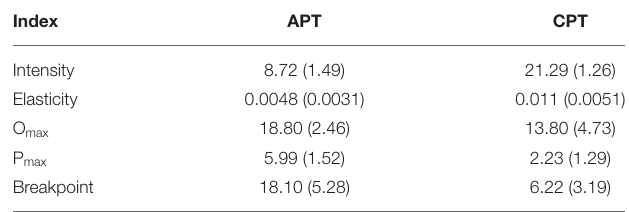
TABLE 1 | Demographics and baseline characteristics ( n = 99). TABLE 2 | Means of alcohol and cigarette demand